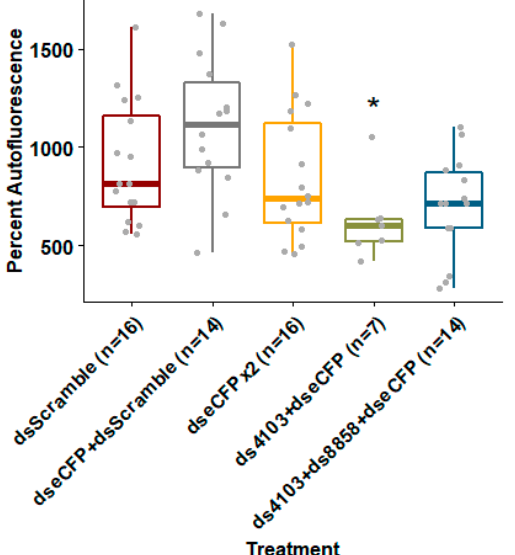
Figure 4. Co-feeding eCFP shRNA with dsRNase shRNA improved depletion of fluorescent protein by RNAi. The shRNA were expressed in E. coli and fed to Ae. aegypti larvae in brewer’s yeast-supplemented agar feeding pellets for five days at 28 ◦ C. Whole larvae of uniform size were placed in conical-bottom 96-well plates and eCFP fluorescence was measured using a Biotek Synergy H1 plate reader. Box-plots show mean and upper and lower quartiles with range whiskers. Wilcoxon rank-sum p -value less than 0.05 relative to dsScramble controls are indicated by *.